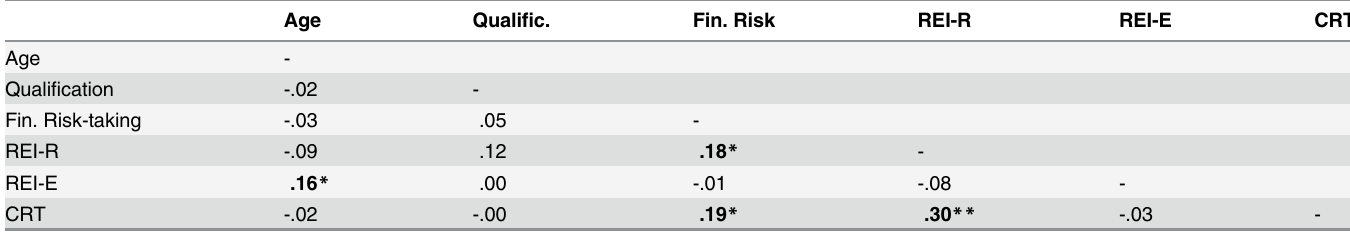
Table 3. Intercorrelations for main measures across all participants groups (n = 152) in Studies 1 and